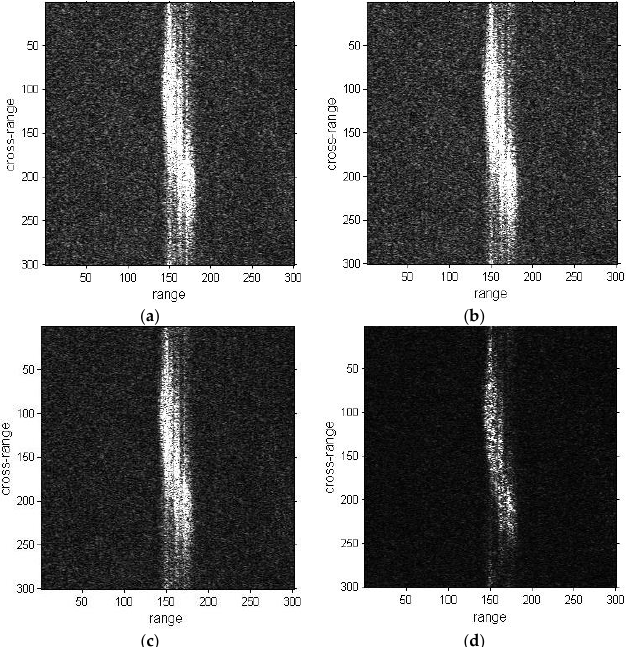
Figure 17. Refocused images of ship06 sub-image. ( a ) Sub-image of ship06; ( b ) Refocused image with the DCT method; ( c ) Refocused image with the PGA method; ( d ) Refocused image with the proposed method.